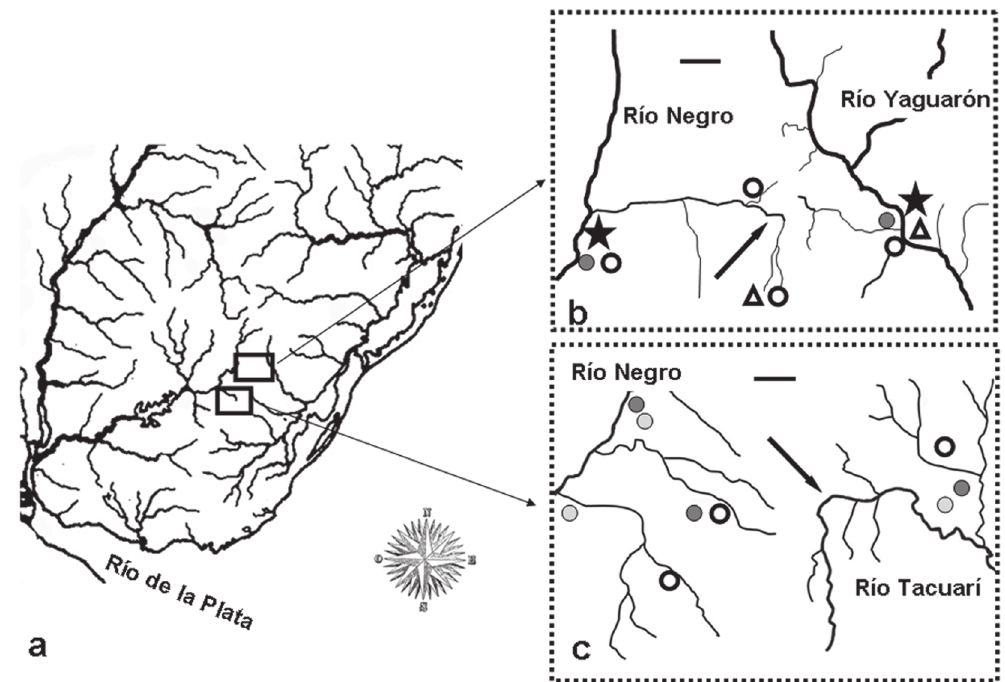
Fig. 5. a. Map of hypothesized areas of drainage rearrangements (empty squares) between río Negro and Laguna Merín tributaries, based on distribution patterns of Austrolebias and rivers morphology (elbows of capture); b. Detailed map of localities of Austrolebias and rivers configurations in río Negro and río Yaguarón; c. Detailed map of localities of Austrolebias and rivers configurations in río Negro and río Tacuarí. Scale bars = 10 km; Black arrows indicate proposed elbow of capture. Austrolebias quirogai (stars), A . arachan (light gray circles), A . vazferreirai (dark gray circles), A . melanoorus (white triangles), and A . affinis species group (white